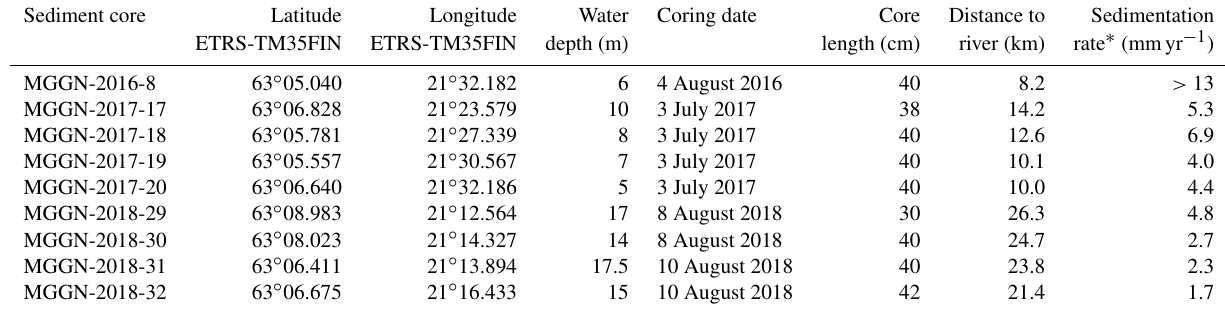
Table 1. Sediment coring locations, water depths, coring dates, core lengths, and distances to the nearest river mouth. Sediment core Latitude Longitude Water Coring date Core Distance to Sedimentation ETRS-TM35FIN ETRS-TM35FIN depth (m) length (cm) river (km) rate ∗ (mmyr − 1